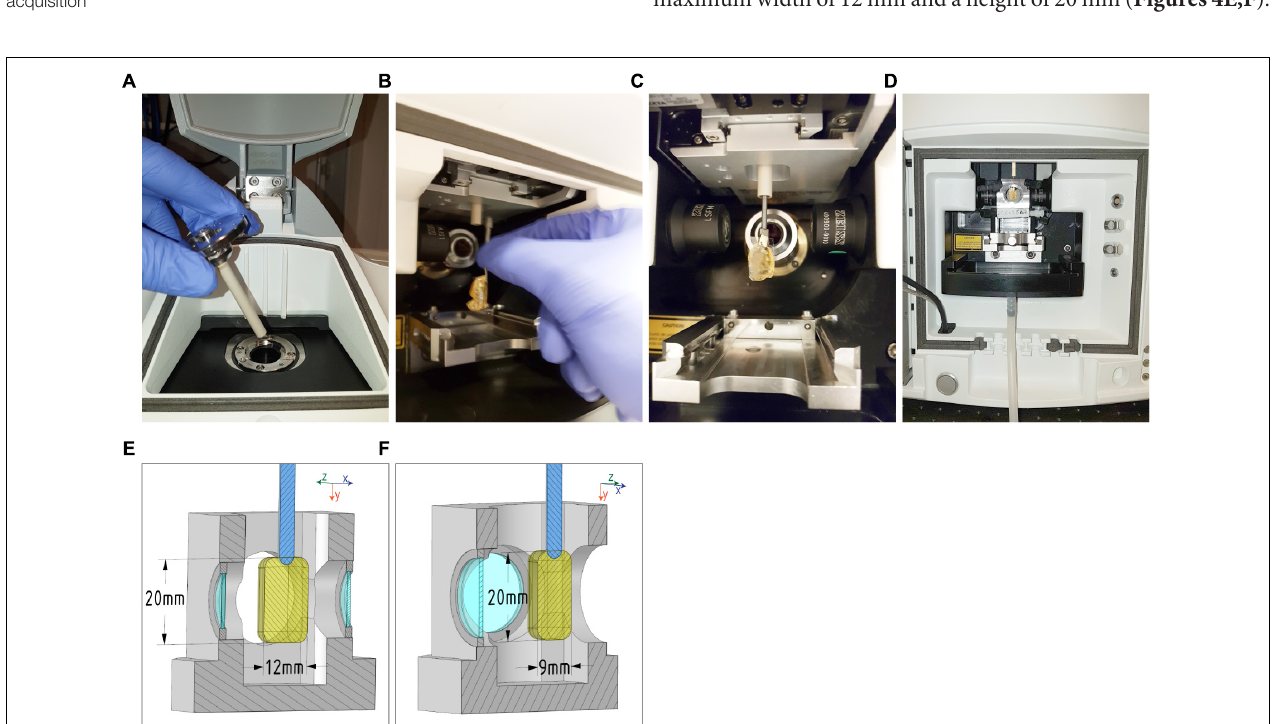
FIGURE 4 | Mounting procedure and maximal sample dimensions for the Zeiss Lightsheet Z1. Top: (A) Insert the sliding rod holder onto the microscope stage, (B) then assemble the adapter (with sample attached) onto the sliding rod holder via the front door cavity. (C) Once in this position, (D) raise the stage as high as possible in order to insert the cell chamber and gently fill it with 25 mL of immersion liquid. Finally, lower the specimen into the immersion liquid of the cell chamber. Bottom: The maximum dimensions that can be acquired with a Zeiss Lightsheet Z1 are shown. The maximum height (22 mm) and length (12 mm) (E) of the sample are applicable to all chambers from Zeiss (Clearing chambers, water chambers, 5 × objective chambers and standard chambers. The internal dimensions of the cell chamber are 20 mm (left-right) by 40 mm (top-down) by 24 mm (back-forth). The 9 mm maximum tissue thickness (F) is estimated from the working distance of the Zeiss Clr Plan-Neofluar 20x/1.0 Corr n.d. 1.45